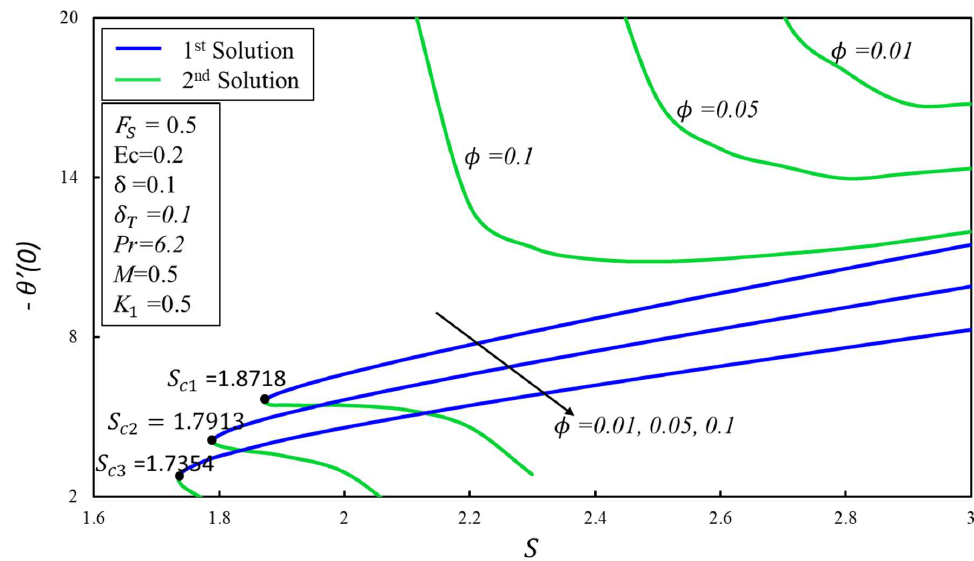
Figure 13. Skin-friction coefficient 𝑓′′(0) against 𝑆 and ∅ .